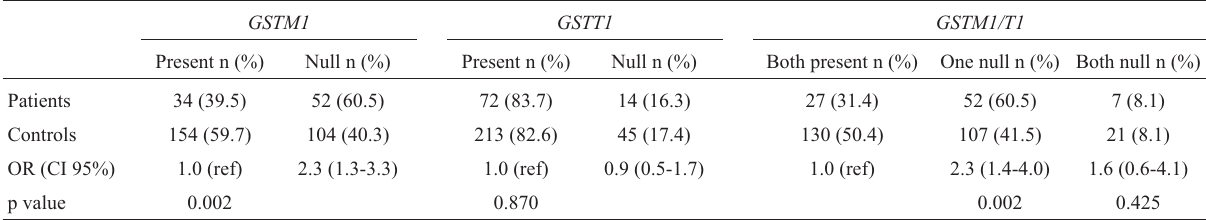
Table 1 - GSTM1 and GSTT1 genotypes in atopic asthma patients and